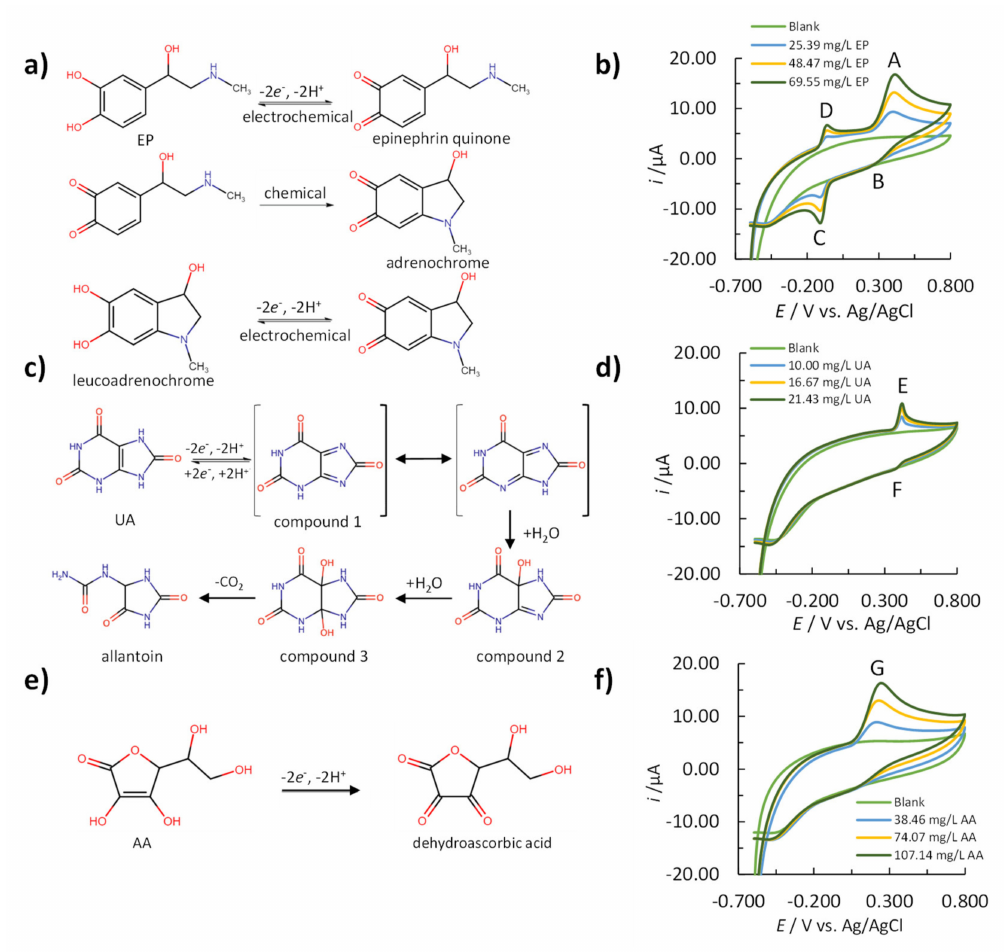
Figure 1. Electrochemical reaction mechanisms for ( a ) EP, ( c ) UA, and ( e ) AA, and measured cyclic voltammograms for ( b ) blank, 25.39 mg / L, 48.47 mg / L, and 69.55 mg / L of EP, ( d ) blank, 10.00 mg / L, 16.67 mg / L, and 21.43 mg / L of UA, and ( f ) blank, 38.46 mg / L, 74.07 mg / L, and 107.14 mg / L of AA in 0.15 M PBS (a potential sweep rate of 50.00 mV /